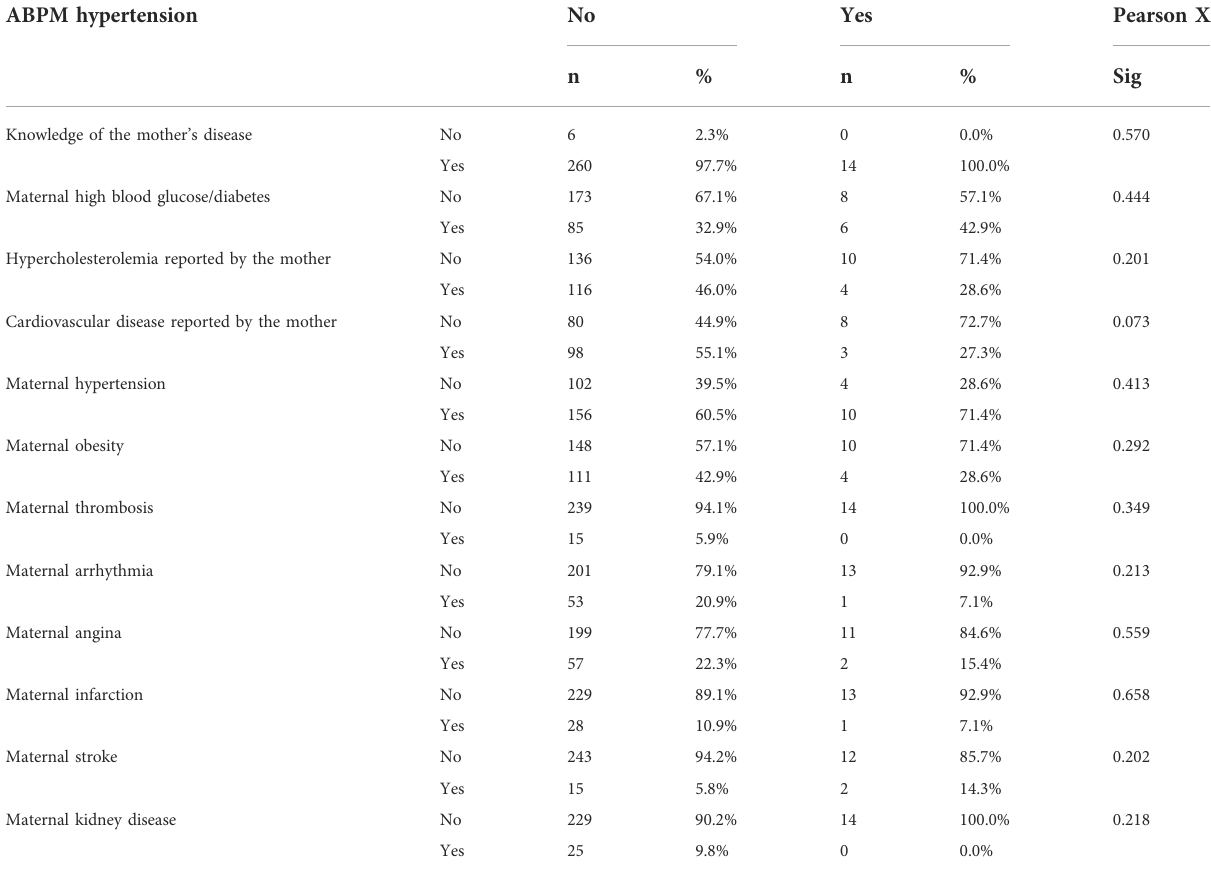
TABLE 5 Evaluation of the presence of hypertension (ABPM) according to maternal comorbidities. ABPM